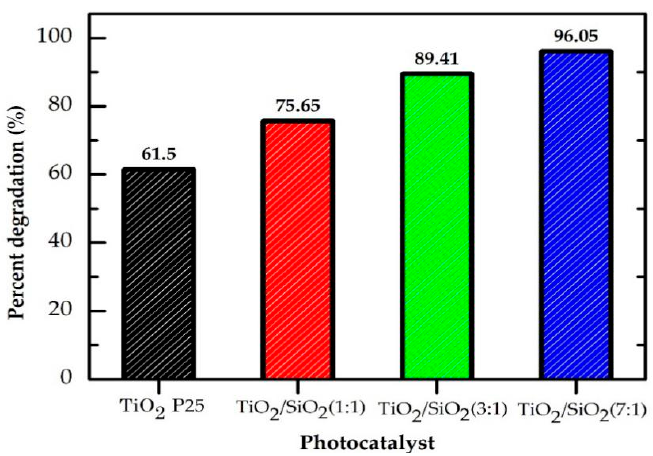
Figure 8. The efficiency diagram of the phenol concentration reduction using various ratios of TiO 2 P25 photocatalyst and TiO 2 /SiO 2 composites.